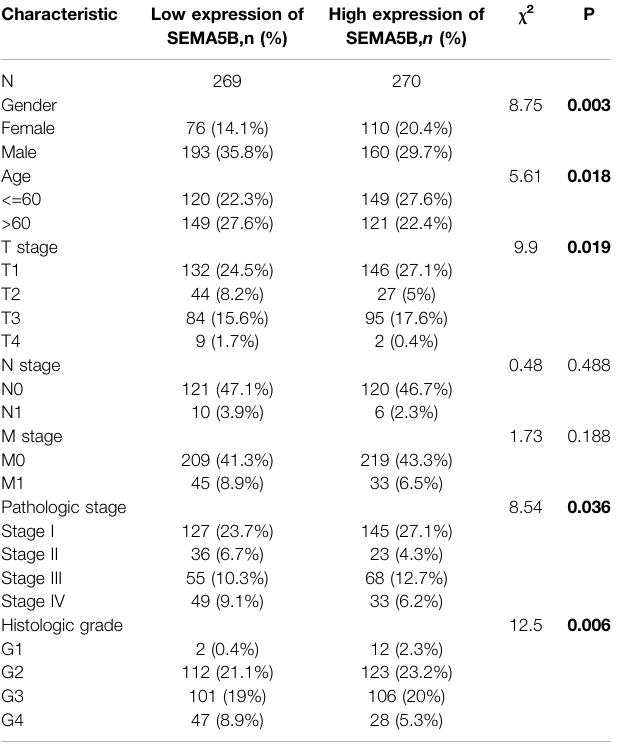
TABLE 1 | Relationship between the clinical features and SEMA5B expression in patients with KIRC. Characteristic Low expression of SEMA5B,n